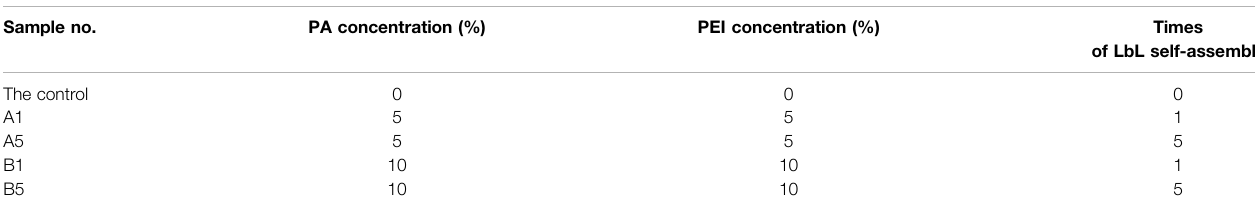
TABLE 1 | Bamboo specimens with different solution concentrations and times of LbL self-assembly with PA-PEI. Sample